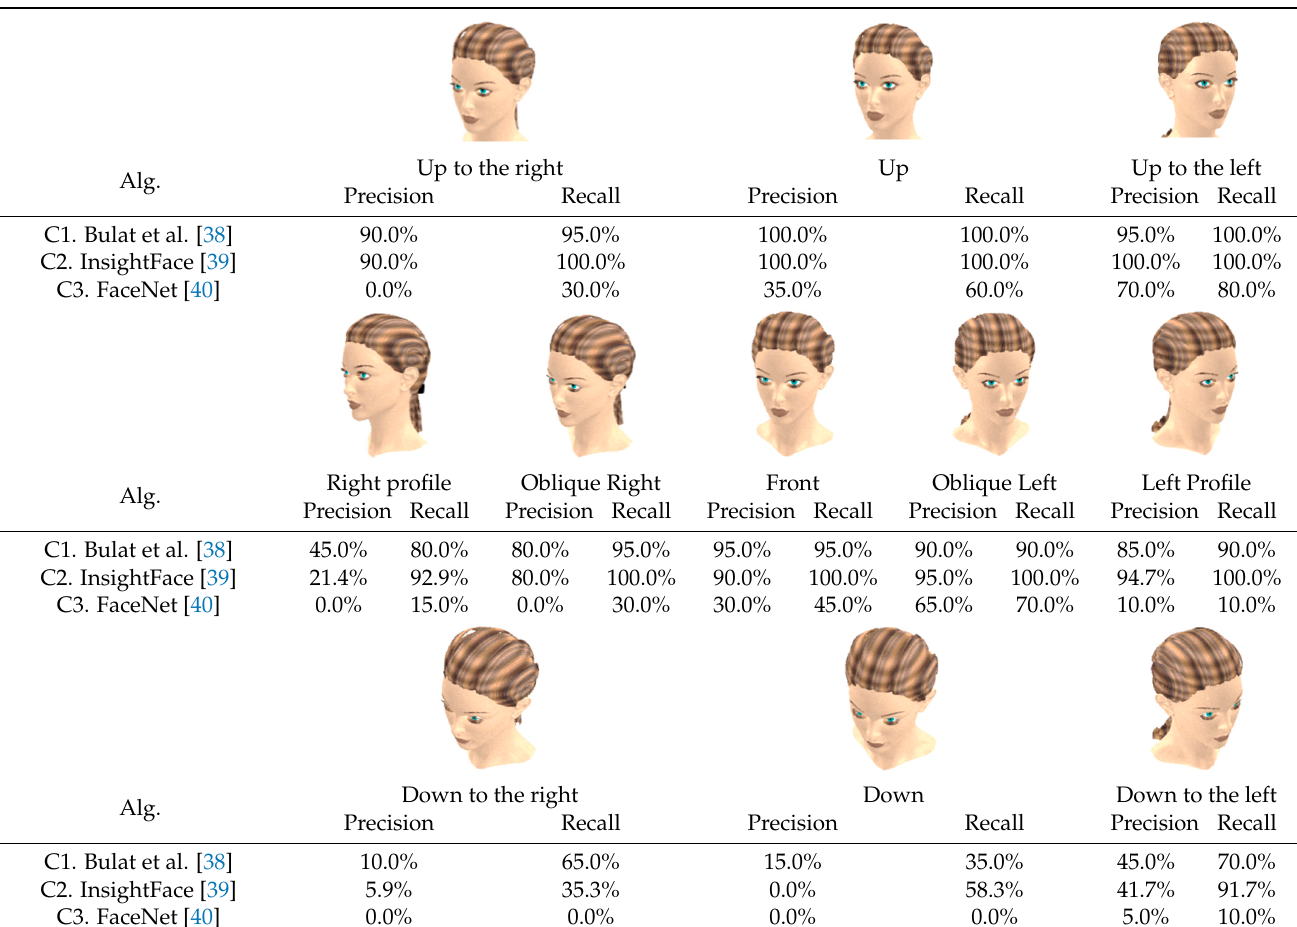
Table 2. Average precision and recall under different lighting settings for the three candidates.